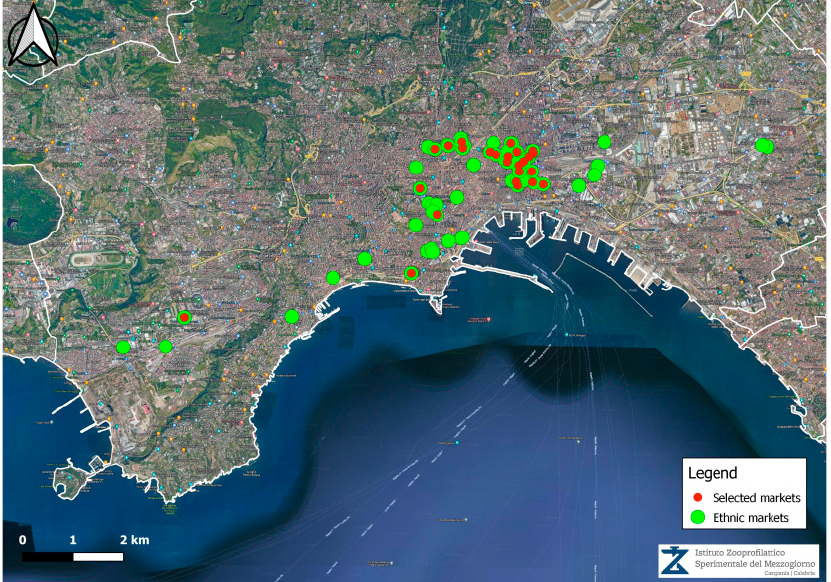
Figure 1. Map of the 72 ethnic markets (green dots) and of the 25 markets selected (red dots). From each market, two food samples were randomly selected according to their availability and were grouped into solid, liquid, spices and meat- or fish-based foods (Table 1). Table 1. Classification of food